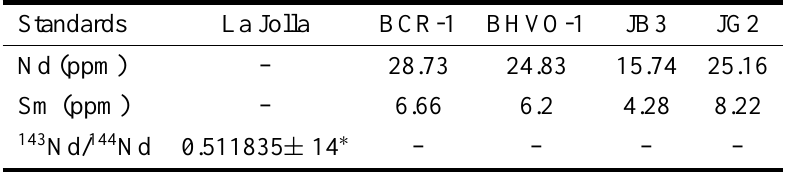
Values for the analysed